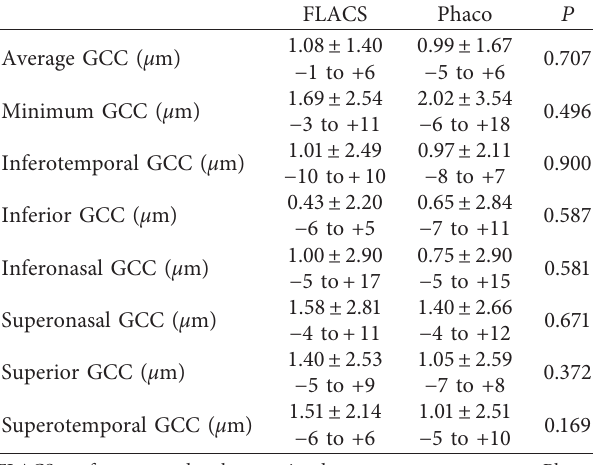
Table 4: Differences in pre- and postoperative ganglion cell complex measurements for femtosecond laser-assisted cataract surgery compared with classic phacoemulsification.